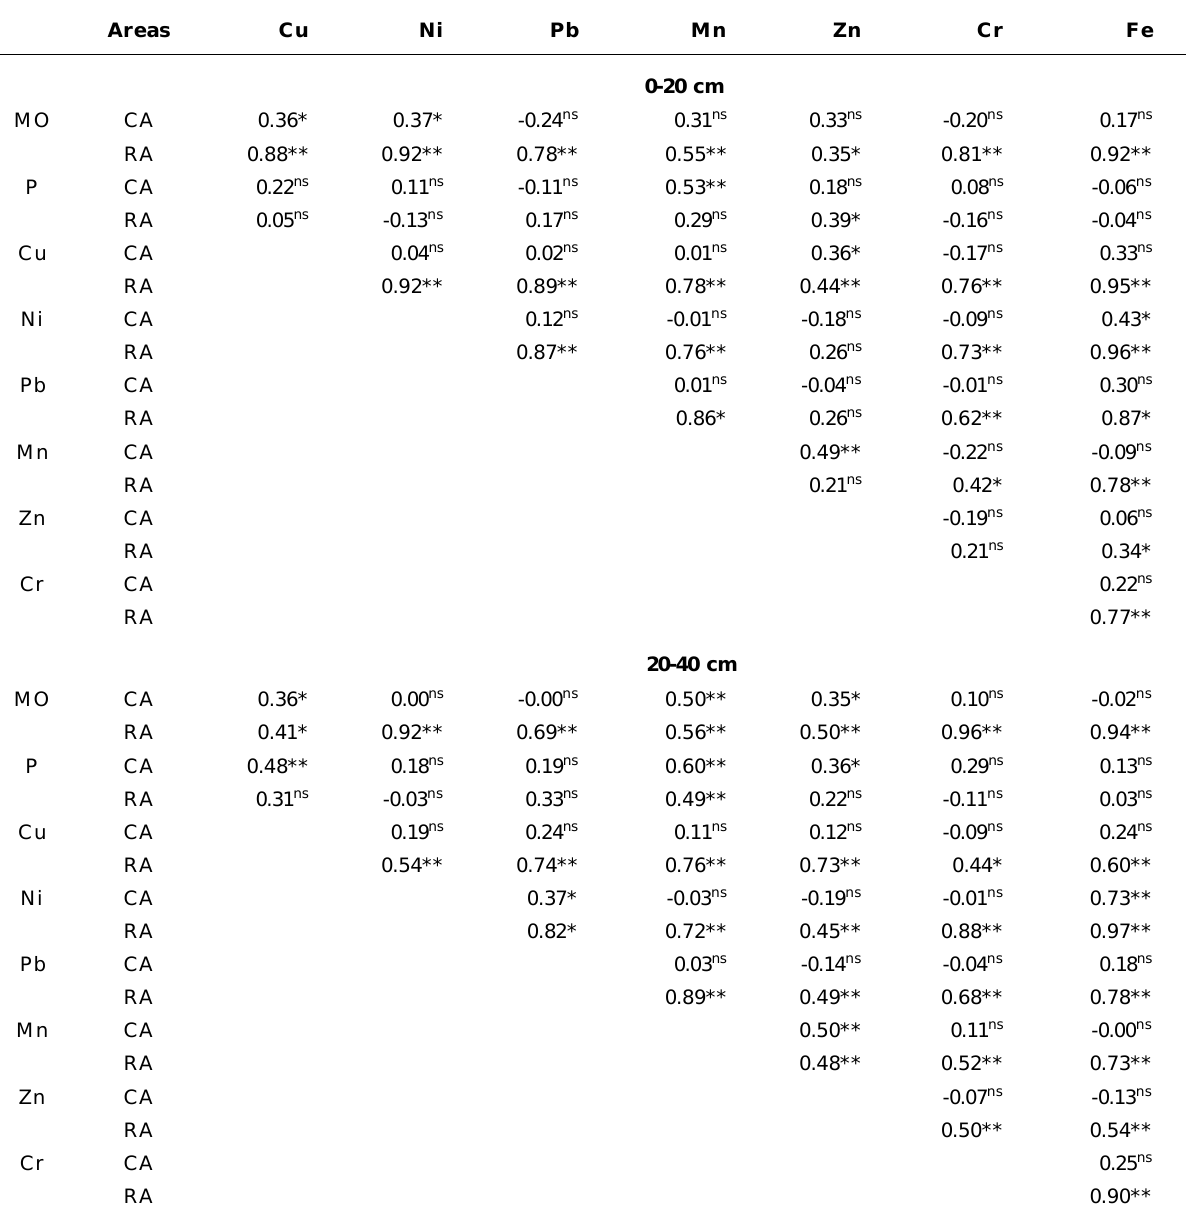
Table 1. Linear correlations between heavy metal contents in soil for cultivated (CA) and reference areas (RA) in two